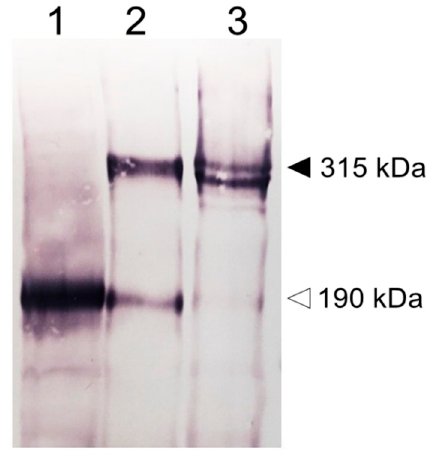
Figure 2. Protein characterization by SDS-PAGE . Stable cell lines expressing human ( 1 ) 190HARE, ( 2 ) Stabilin-2 or 315HARE, and ( 3 ) Stabilin-1 were prepared as whole cell lysates and 20 μ g of lysates were separated by 5% denaturing gel electrophoresis without reduction. The dark arrowhead (315 kDa) indicates the monomer of Stabilin-2 and doublet of Stabilin-1 and the open arrowhead (190 kDa) indicates the presence of the 190HARE in cell lysates expressing a construct that only codes for the 190HARE and Stabilin-2. All plasmid constructs (pcDNA5/FRT/V5-6xHis, Invitrogen, Carlsbad, CA) used to express these proteins contained the cytomegalovirus promoter for protein expression and C- terminal tags, 6xHis and V5. Anti-V5 antibody was used to detect the recombinant protein followed by a secondary antibody for standard colorimetric detection with alkaline phosphatase.